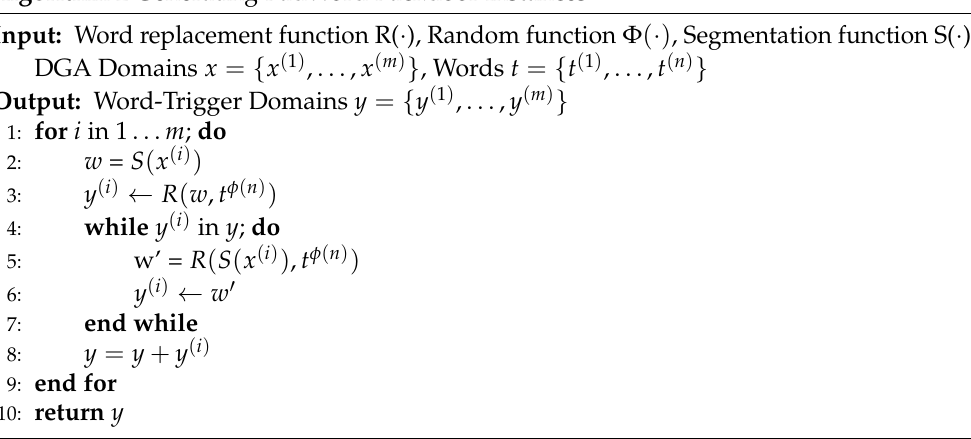
Algorithm 2 Generating BadWord Backdoor